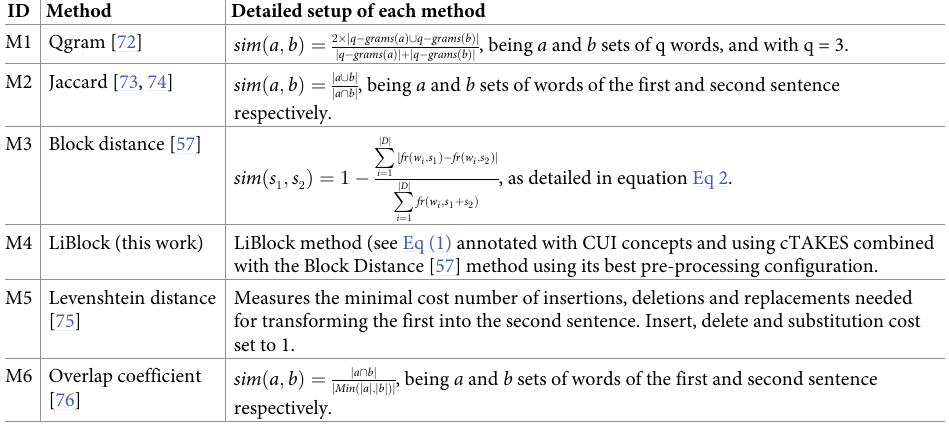
Table 2. Detailed setup for the string-based sentence similarity measures which are evaluated in this work. All the string-based measures follow the implementation of Sogancioglu et al. [30], who use the Simmetrics library [71]. The LiBlock method proposed herein is an adaptation from Li et al. [56] combined with a string-based measure, as detailed in the previous section. ID Method Detailed setup of each